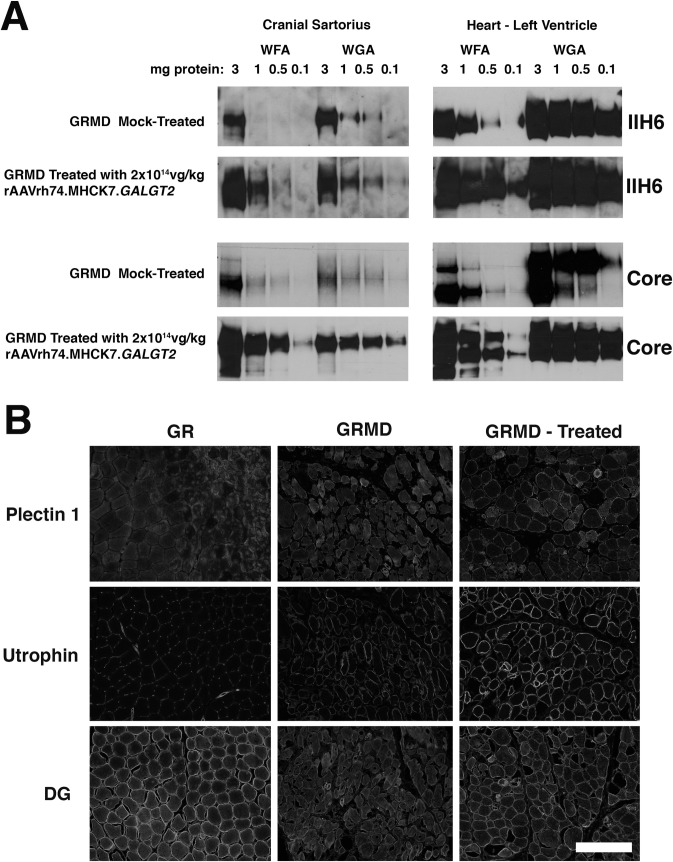
Expression of glycosylated α-dystroglycan and utrophin in response to rAAVrh74.MHCK7.GALGT2 treatment of GRMD dogs.(A) Lectin precipitations of non-ionic detergent whole protein lysates were completed using different amounts of cellular protein ranging from 0.1- to 3.0mg. Precipitates were solubilized in SDS denaturation buffer, separated by SDS-PAGE, and immunoblotted for α dystroglycan using the IIH6 monoclonal antibody, which recognizes functionally glycosylated αDG, or with antiserum made to the CORE DG polypeptide. The 160kDa region of the gene is shown for IIH6 and the 100-160kDa region is shown for CORE. WFA was used to precipitate α-dystroglycan containing βGalNAc, which is made by GALGT2, while WGA was used to precipitate glycosylated α dystroglycan not containing βGalNAc. (B) Muscle sections taken from the cranial sartorius muscle of normal untreated wild type golden retriever (GR), untreated golden retriever muscular dystrophy (GRMD), or GRMD dogs treated with 2x1014vg/kg rAAVrh74.MHCK7.GALGT2. Time-matched exposures are shown comparing immunostaining for dystrophin surrogates plectin 1 and utrophin as well as dystroglycan (DG). Bar is 200μm.